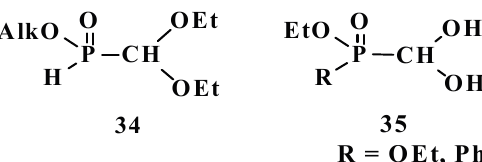
Figure 3. Molecular structure of alkyl (diethoxymethyl)phosphinate 34 and phosphorylated formaldehyde hydrates 35